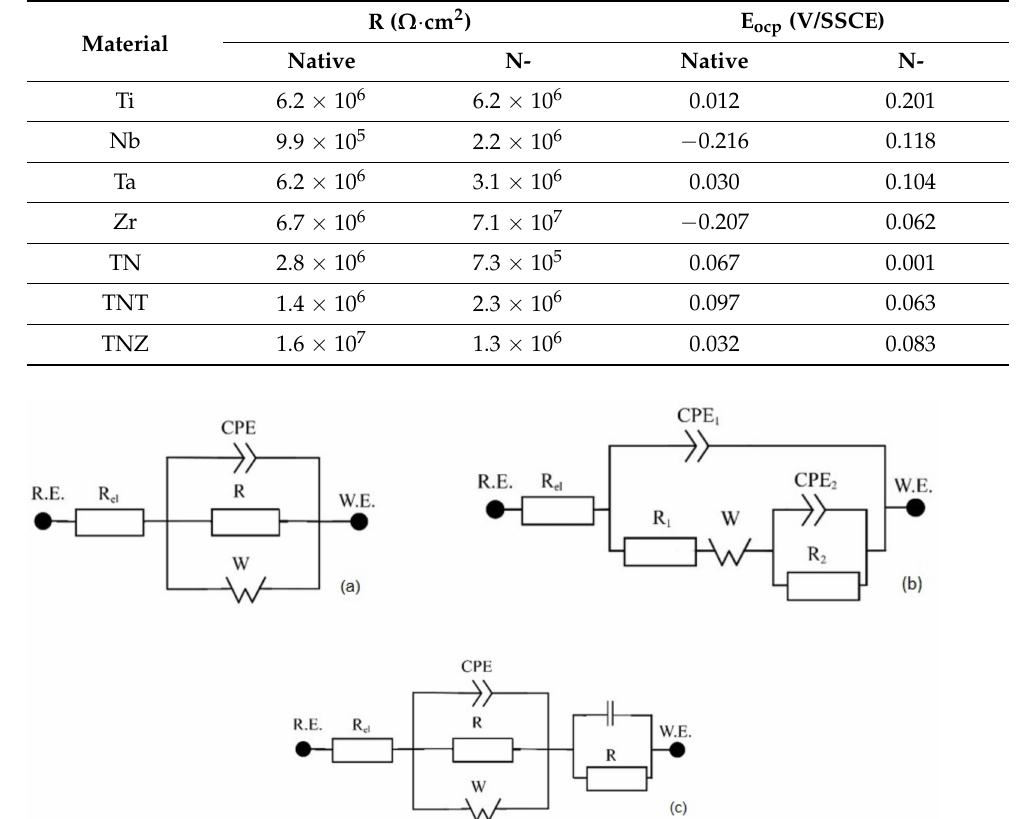
Figure 2. The equivalent circuits used for the evaluation of impedance spectra. Circuit ( a ) was used for samples Ti, Nb, N-Nb, Ta, N-Ta, Zr, TN, N-TN, TNT, N-TNT, TNZ, N-TNZ; circuit ( b ) was used for N-Ti, ( c ) was used for